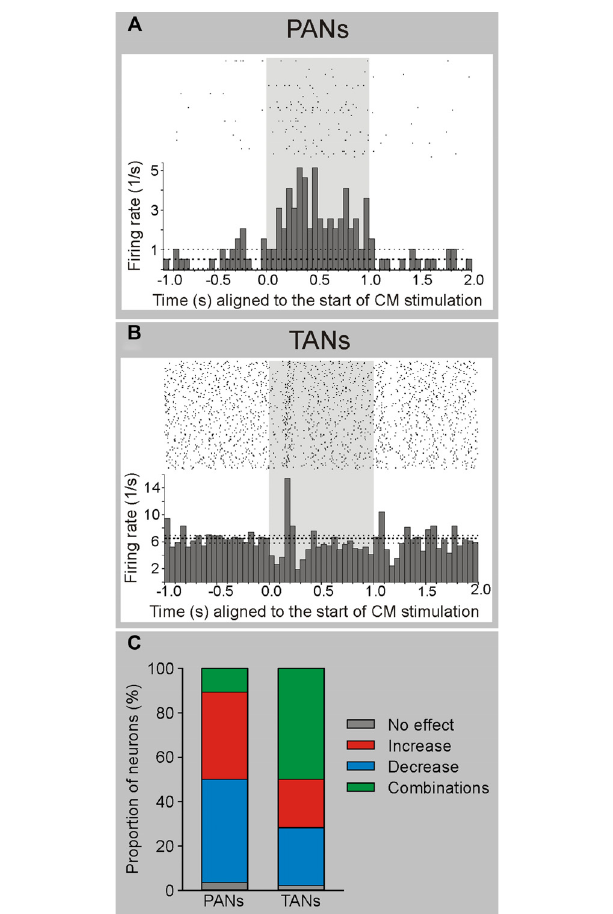
FIGURE 3 | Electrophysiological responses of striatal neurons to electrical stimulation of CM in awake monkeys. Electrical stimulation (100 Hz, 100 pulses-shaded area) of CM evokes responses in PANs (putatively MSNs) and TANs (putatively cholinergic interneurons) in awake rhesus monkeys. (A) Example of a PAN responding with increased firing to electrical CM stimulation. (B) Example of a TAN responding with a brief decrease followed by an increase in firing to CM stimulation. The histograms and rasters are aligned to the start of stimulation trains. (C) Summary of responses. The majority of PANs display increases or decreases in firing rate, while most TANs present combinatory (increases and decreases) responses following CM stimulation (see Nanda et al., 2009 for more